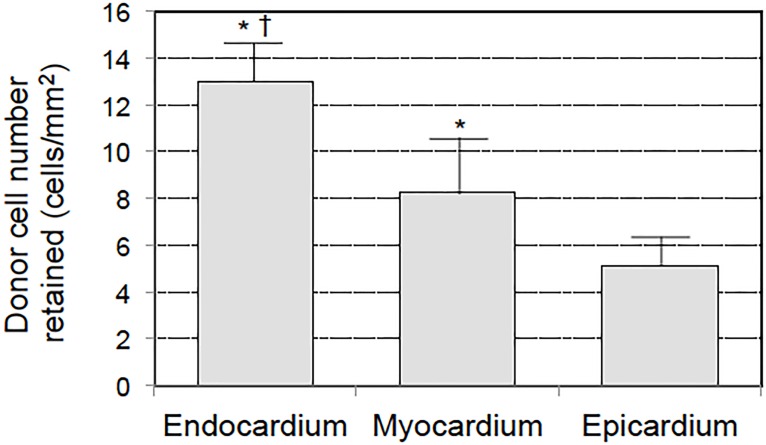
Different distribution of retained BMMNC between ventricular layers.At 5 minutes after IC injection of 8x106 PKH67-labeled BMMNC, the number of donor cells within the endocardium-side myocardium, central myocardium and epicardium-side myocardium were counted in cross-section of immunohistolabelling samples. The concentration of cells progressively increased from the epicardium to the endocardium (n = 4, p<0.0001, One-way ANOVA followed by Bonferroni post-hoc test).